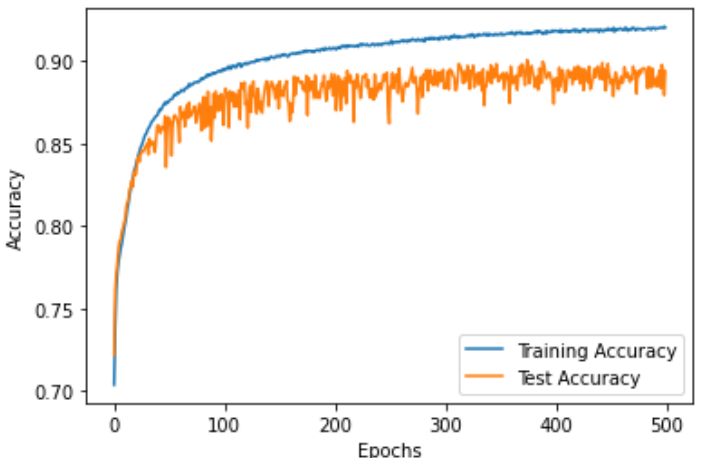
Figure 2. The accuracy curve for the EMG data classification of the left side using the proposed CNN architecture.